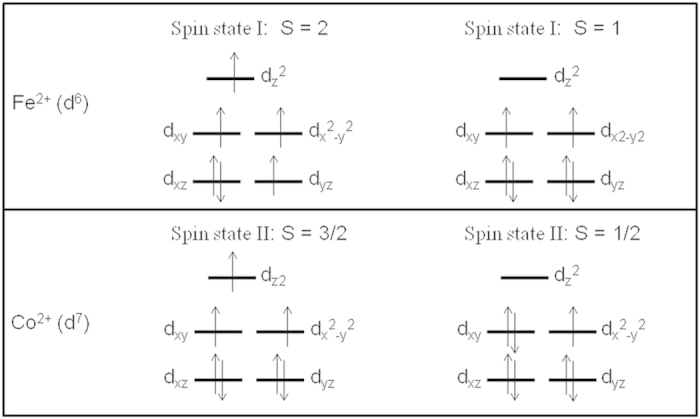
Possible ground spin states of Fe2+ and Co2+ in 1 and 2.